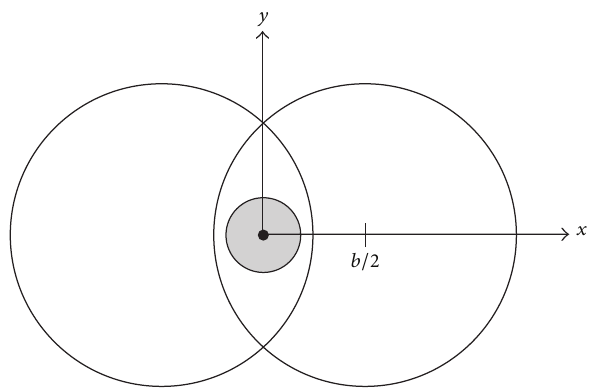
Figure 1: Heavy-ion collision geometry as seen along the collision axis 𝑧 . Adapted from